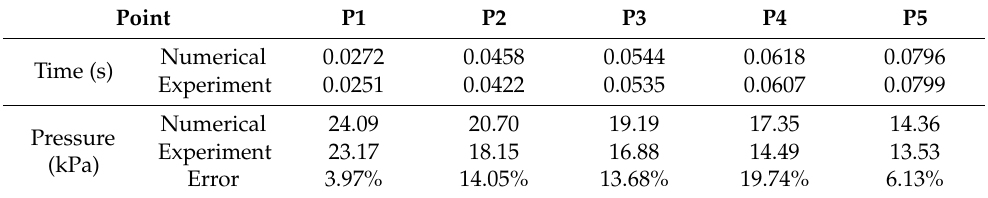
Table 9. Comparison of slamming peak value by different methods (Case 4). Point